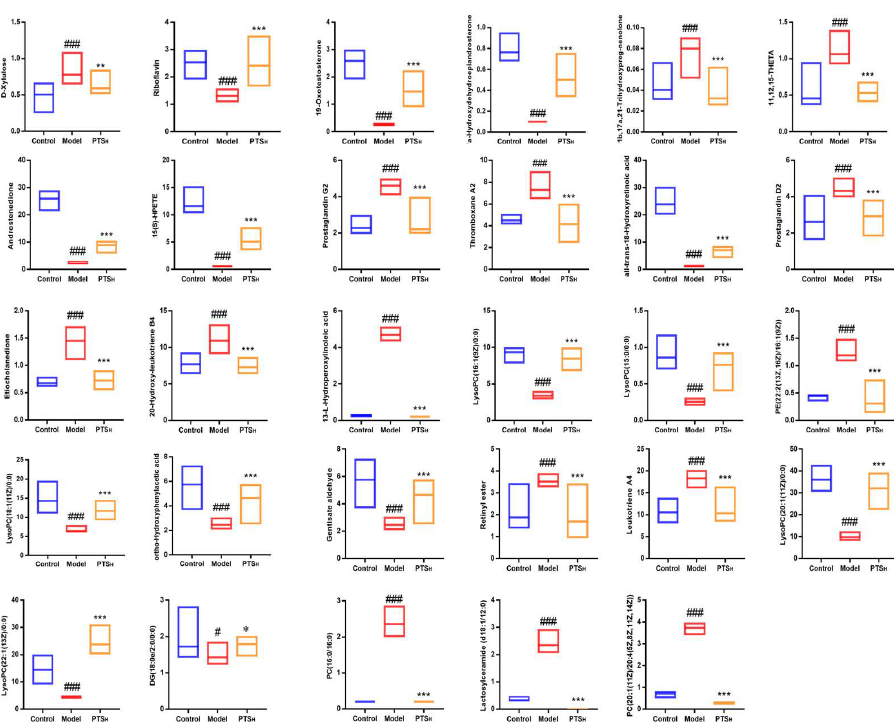
Figure 5. Each biomarker’s concentration in the control, model, and PTS-H groups’ serum or colon. Data are presented as means ± SDs (n = 10). Compared with control group, # p < 0.05 and ### p < 0.001; compared with model group, * p < 0.05, ** p < 0.01, and *** p < 0.001.